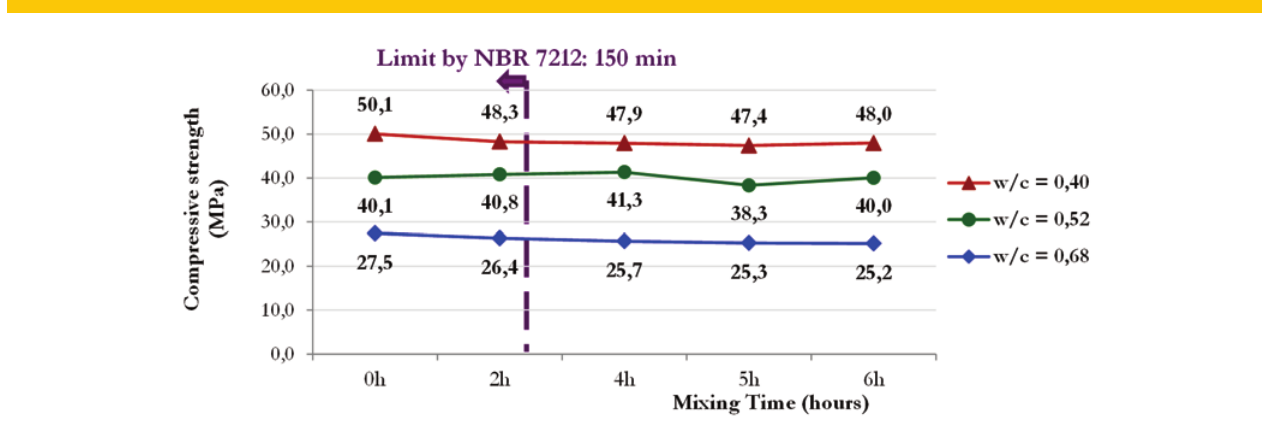
Figure 3 – Average results of compressive strength at 28 days of concrete produced in